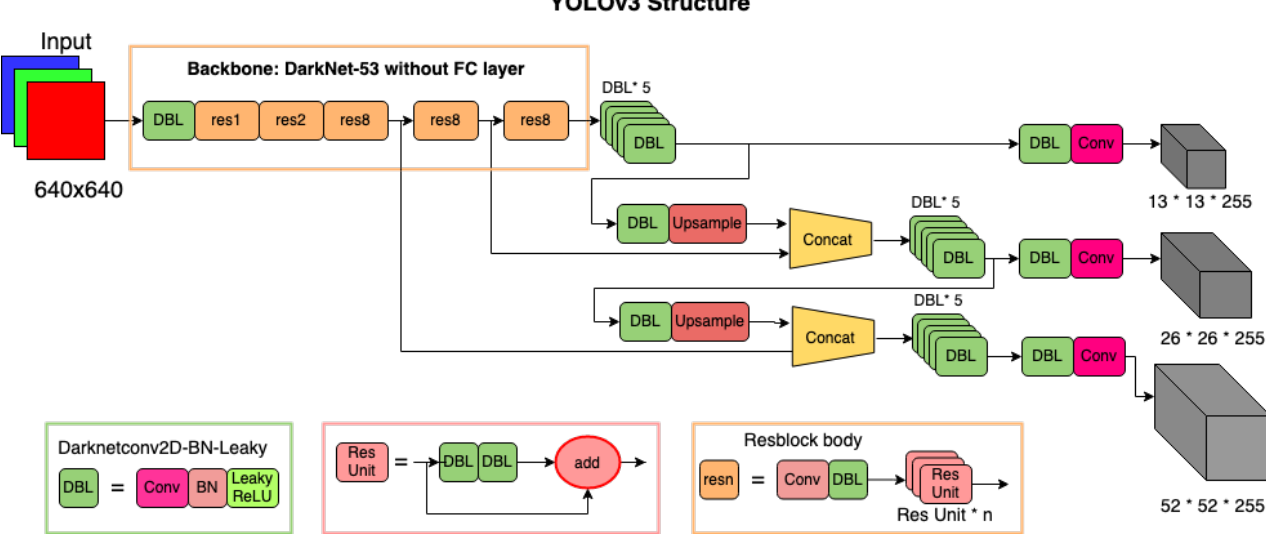
Figure 3. Network architecture of YOLOv3 (adapted from [53] and modified) with a backbone of